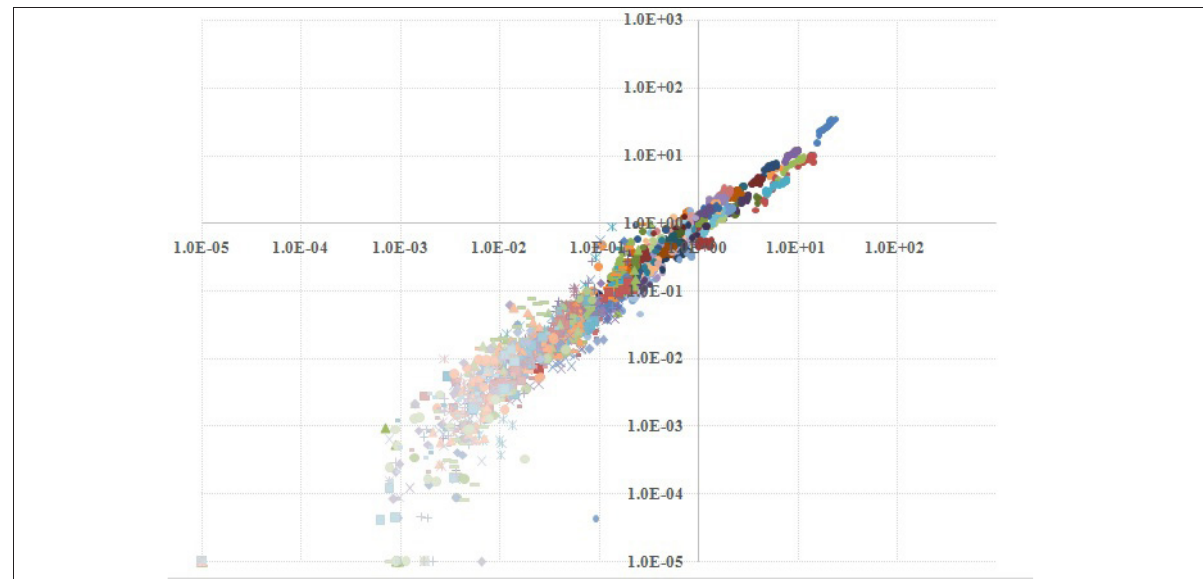
Figure 2: Logarithmic scale of the diagram (Pm,Cm) for all countries in the study period